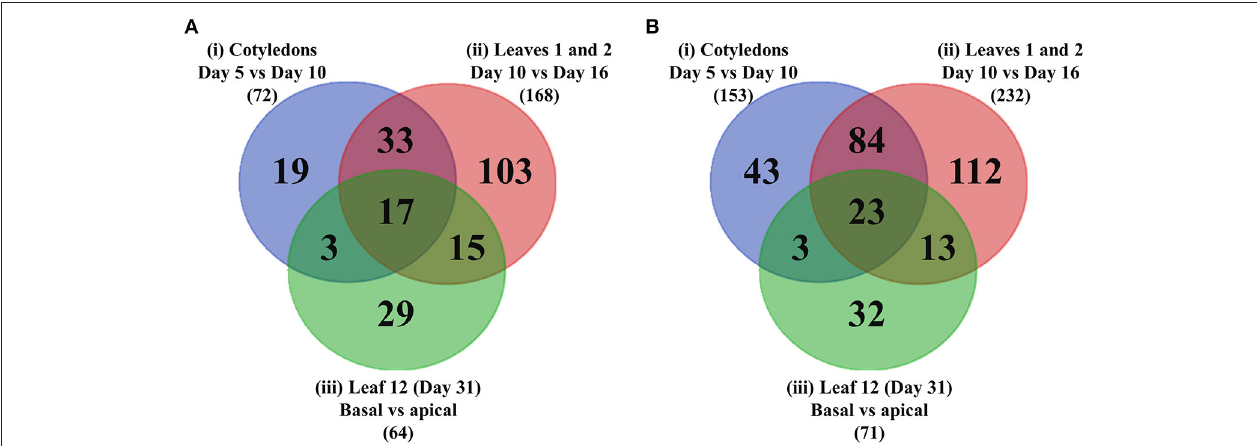
FIGURE 6 | Venn diagrams showing intersections of transcription factors differentially up- or –down-regulated across wall ingrowth deposition in PP TCs of different organs from Arabidopsis grown. (A) Up-regulated genes. (B) Down-regulated genes. In each case the three circles represent the three experimental comparisons: Blue—cotyledons at day 5 vs. day 10; Red - first leaves at day 10 vs. day 16; Green - basal vs. apical thirds of Leaf 12 at day 31. Total number of differentially regulated genes in each of the three experimental comparisons, i.e., (i)–(iii), for each category is indicated in brackets. TABLE 2 | Transcription factors (17 in total) showing differential up-regulation in all three experimental comparisons analyzing wall ingrowth deposition in PP TCs of Arabidopsis. Locus a Symbol b Family c